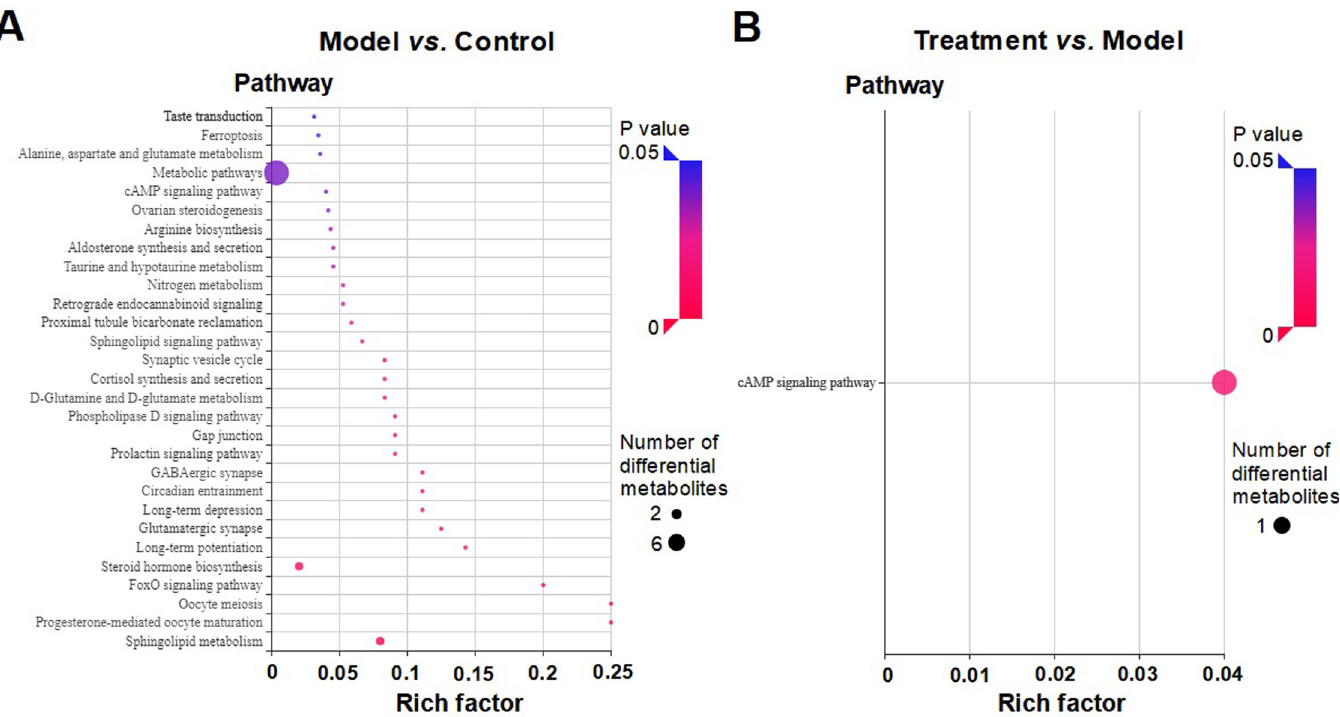
Fig 6. KEGG enrichment analysis of differential metabolites between the control group and the model group (A), and between the model group and the treatment group (B). The X-axis indicates rich factor and the Y-axis represents the terms of the KEGG pathways. The size of circle indicates the number of differential metabolites and the color of circle represents P-value.